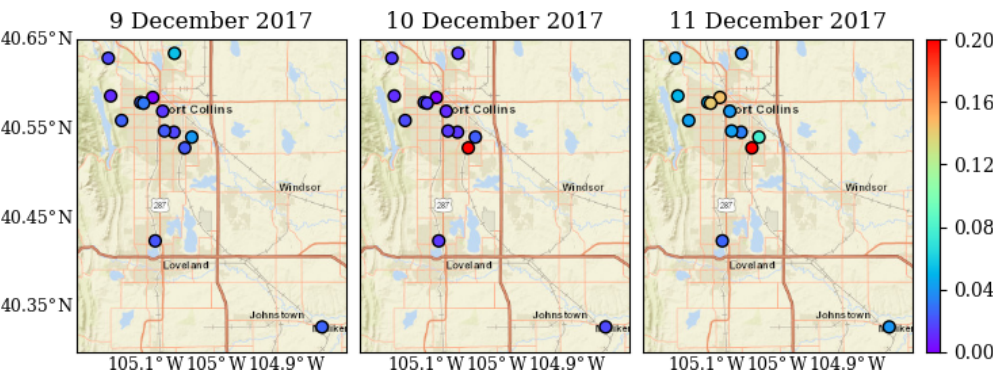
Figure 7. Map of the 440nm AOD measurements for 9–11 December 2017. Maps generated using World Street Maps (credit: Esri, HERE, Garmin, USGS, Intermap, INCREMENT P, NRCan, Esri Japan, METI, Esri China – Hong Kong, NOSTRA, ©OpenStreetMap contributors,